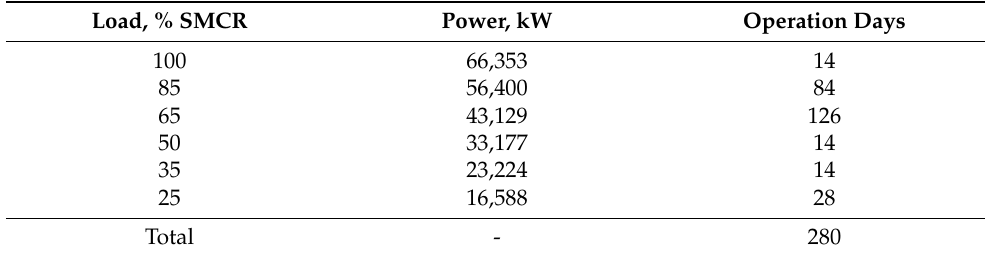
Table 5. Operation profile